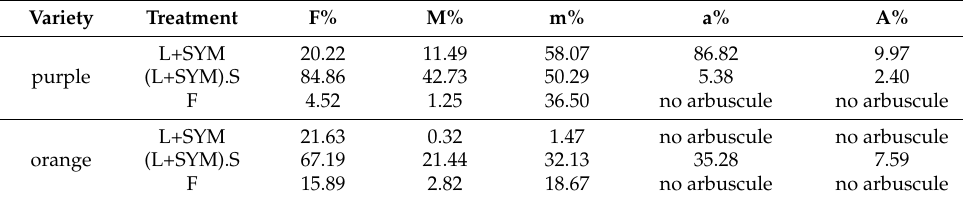
Table 2. Mycorrhizal parameters (F%, A%, a%, M% and m%) within different treatments and